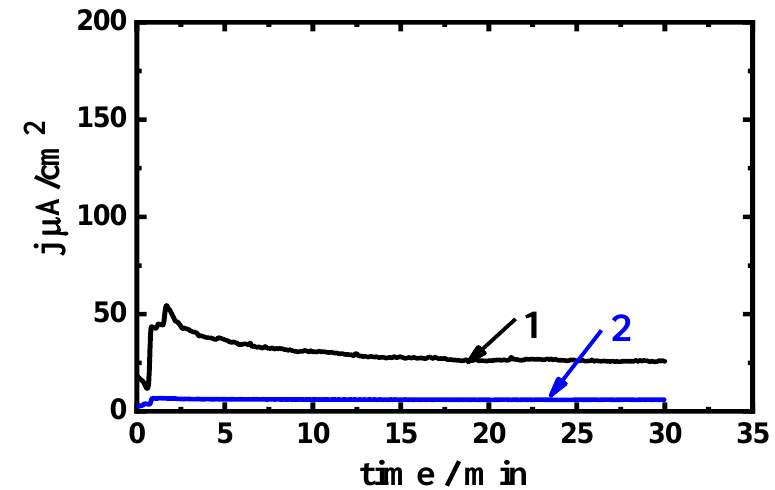
Figure 10. Change of current with time at 300 mV for (1) Ti-6%Al and (2) Ti-6%Al-4%V alloys after immersion in 3.5% NaCl solution for 24 h.